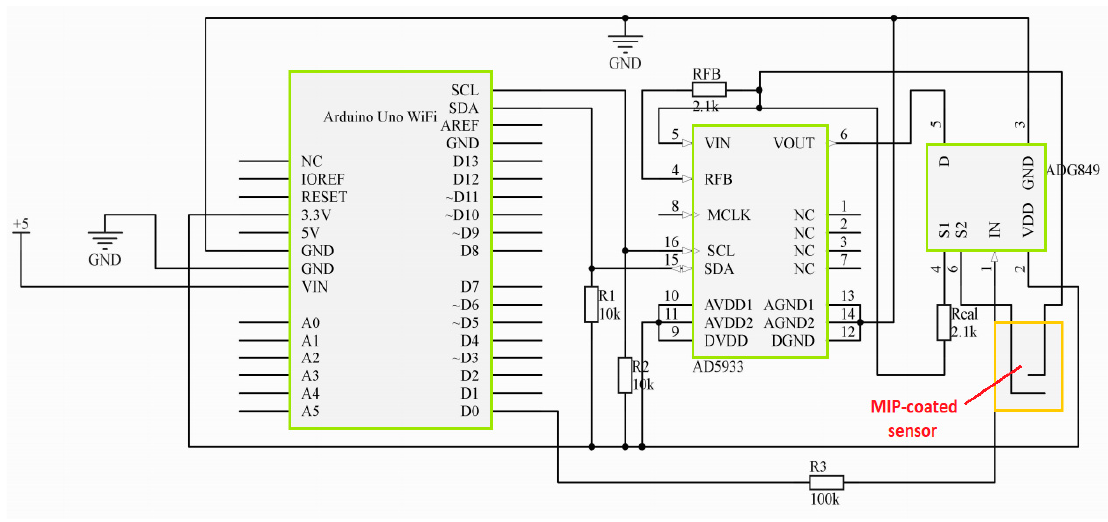
Figure 6. Circuit diagram of the proposed point of care device.